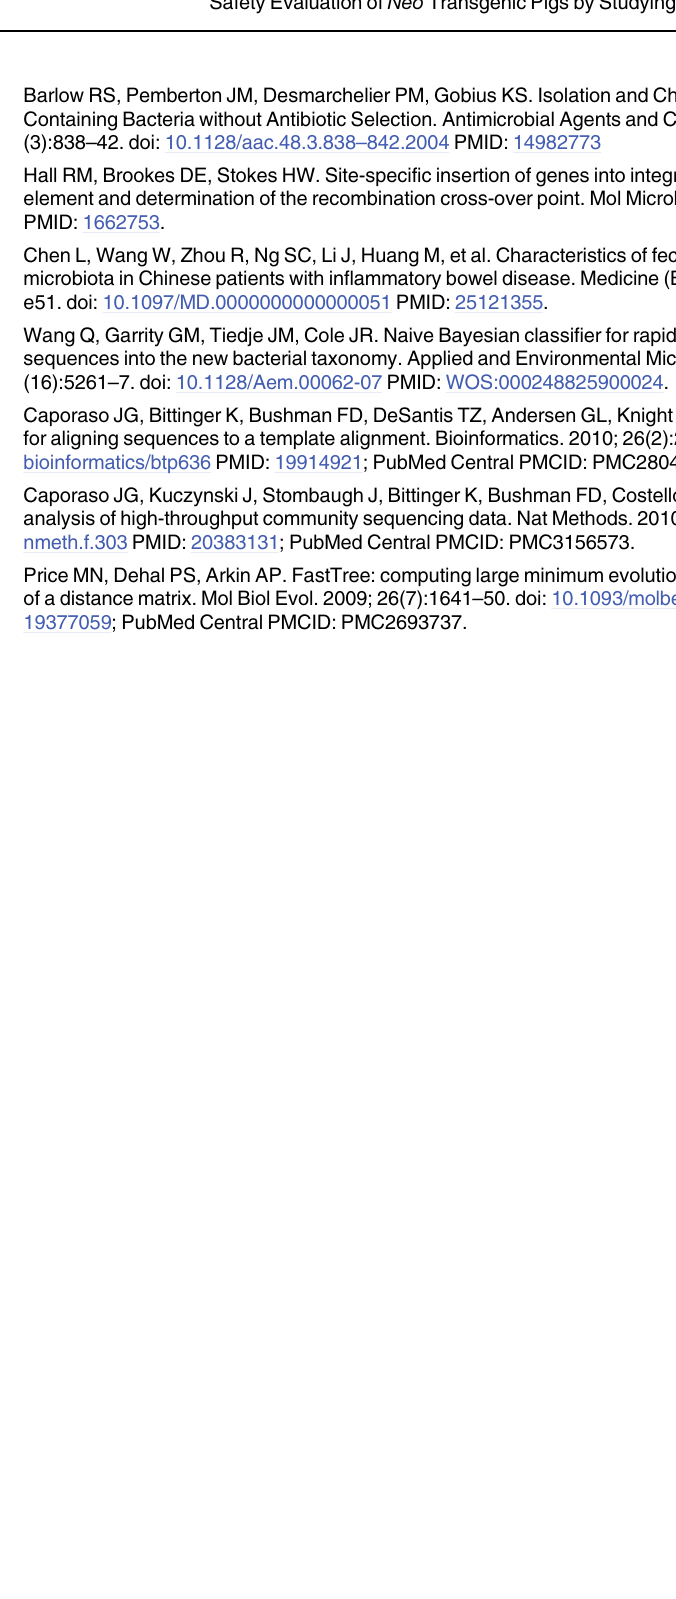
PLOS ONE | DOI:10.1371/journal.pone.0150937 March 11,